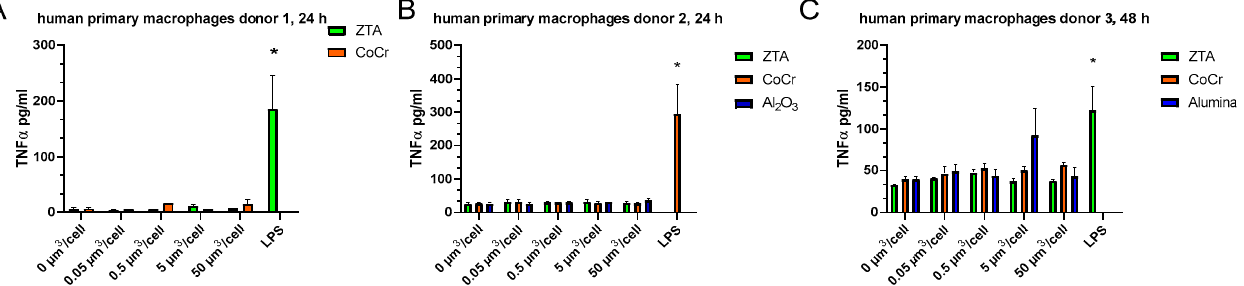
Figure 4. ZTA and CoCr particles do not induce TNF- α secretion in human primary macrophages. Human primary macrophages were treated with Al 2 O 3 , ZTA, or CoCr particles, and the level of TNF- α was measured in the supernatant 24 h ( A , B ) and 48 h ( C ) after addition of particles by ELISA. The results are expressed as the mean ± SEM. *— p < 0.05.